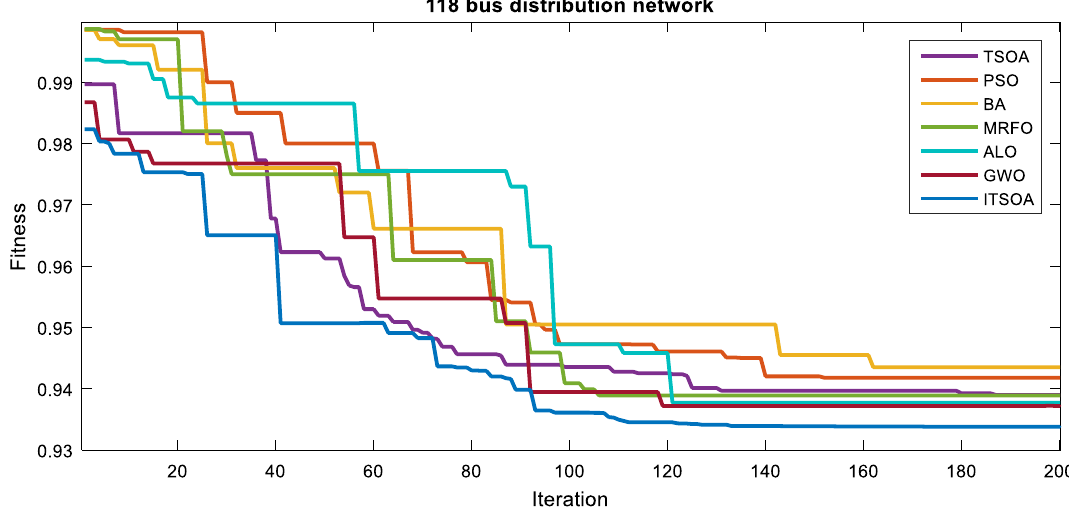
Figure 9. Convergence process of the algorithms in multiobjective reconfiguration solution, 118-bus network.